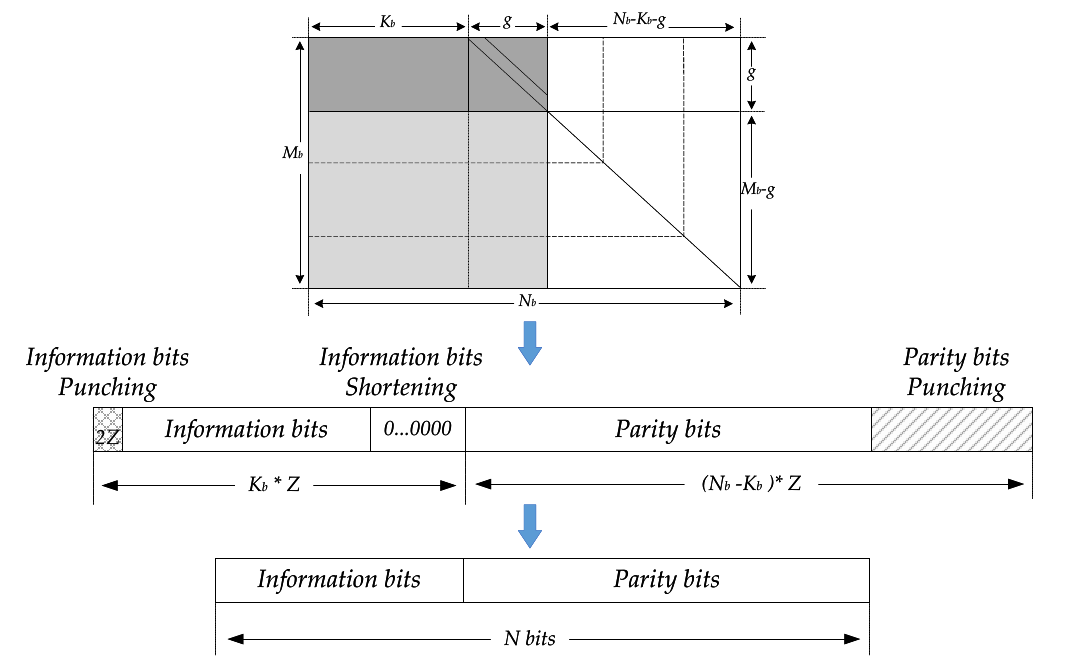
Figure 4. Parity matrix structure and parameters, punching and shortening of 5G LDPC